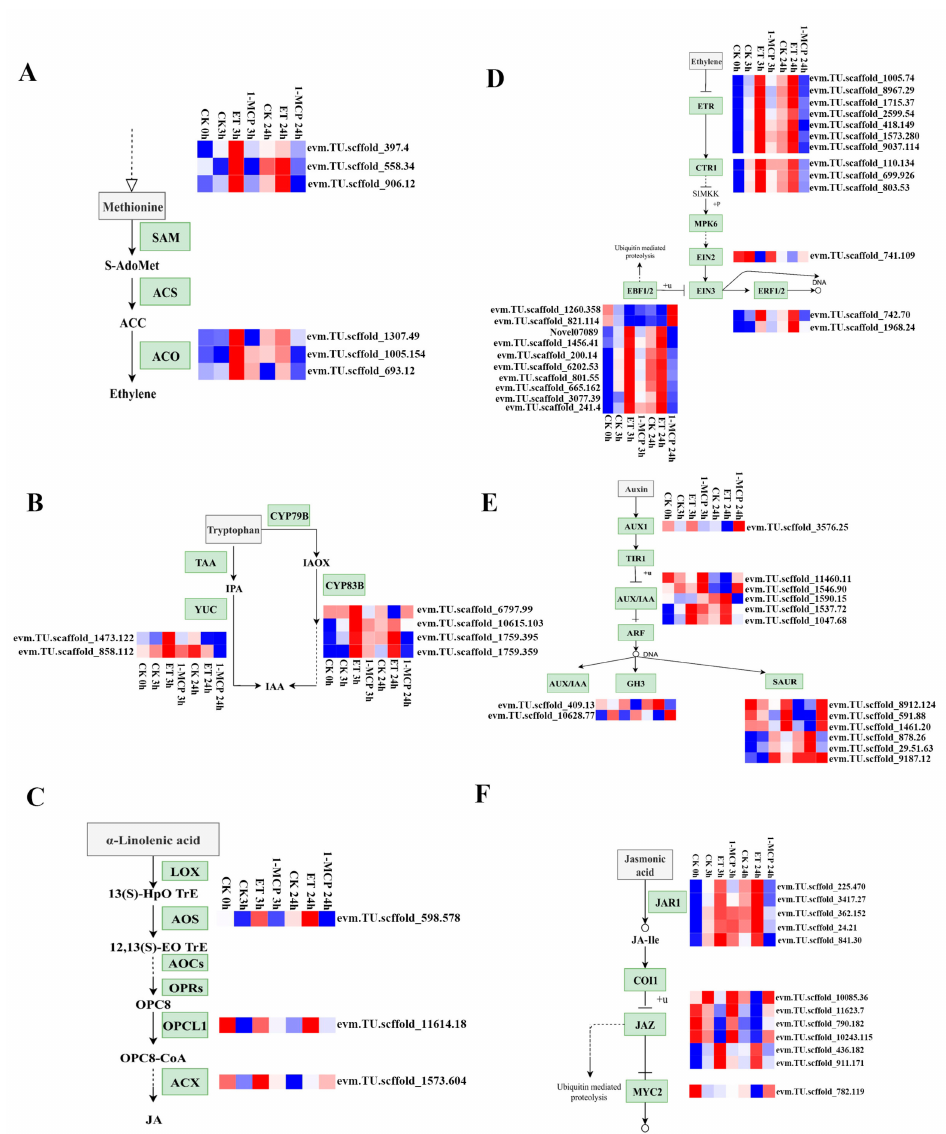
Figure 3. DEGs of plant hormone biosynthesis and signaling. ( A ) Ethylene biosynthesis-related genes. ( B ) IAA biosynthesis-related genes. ( C ) JA biosynthesis-related genes. ( D ) Ethylene signaling-related genes. ( E ) IAA signaling-related genes. ( F ) JA signaling-related genes. Different color bands represent the different expression levels of the individual samples. The red bands represent high expression levels and the blue bands represent low expression levels. DEGs, differentially expressed genes; IAA, indole-3-acetic acid; JA,